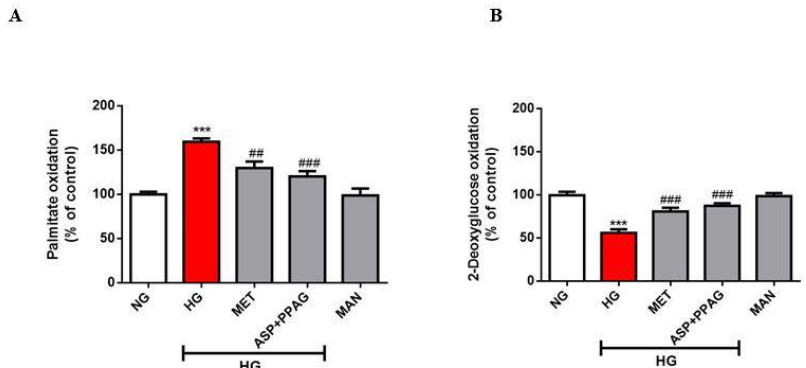
Figure 1. The combination e ff ect of aspalathin (ASP) and phenylpyruvic acid-2- O - β - d -glucoside (PPAG) in comparison to metformin (MET) in ameliorating impaired myocardial substrate metabolism, as measured using palmitate ( A ) and 2-deoxyglucose ( B ) oxidation. H9c2 cardiomyocytes were exposed to 33 mM glucose (HG) for 48 h before treatment with a combination of ASP and PPAG, as well as MET, at a dose 1 µ M for 6 h. Mannitol (MAN) at a concentration of 33 mM was used to rule out the e ff ect of osmolarity. Results are expressed as the mean ± SEM of three independent experiments relative to the normal glucose (NG) control (5.5 mM). *** p < 0.001 versus NG control; ## p < 0.01 and ### p < 0.001 versus HG control.